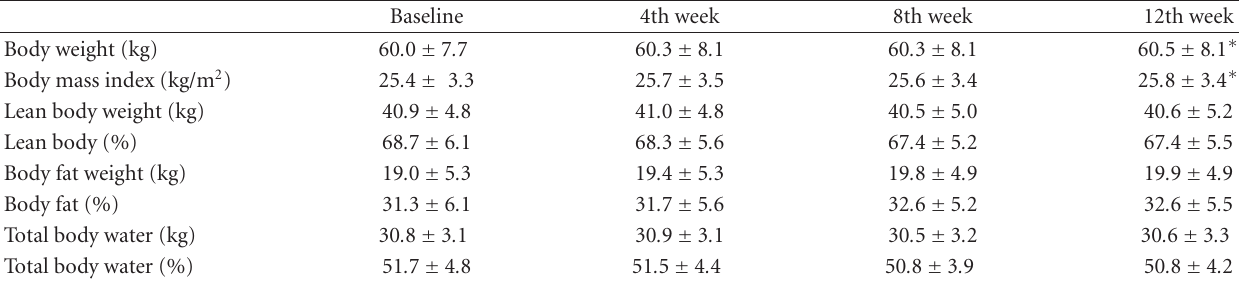
Table 2: Mean ± SD of the body weight, BMI, and body composition.